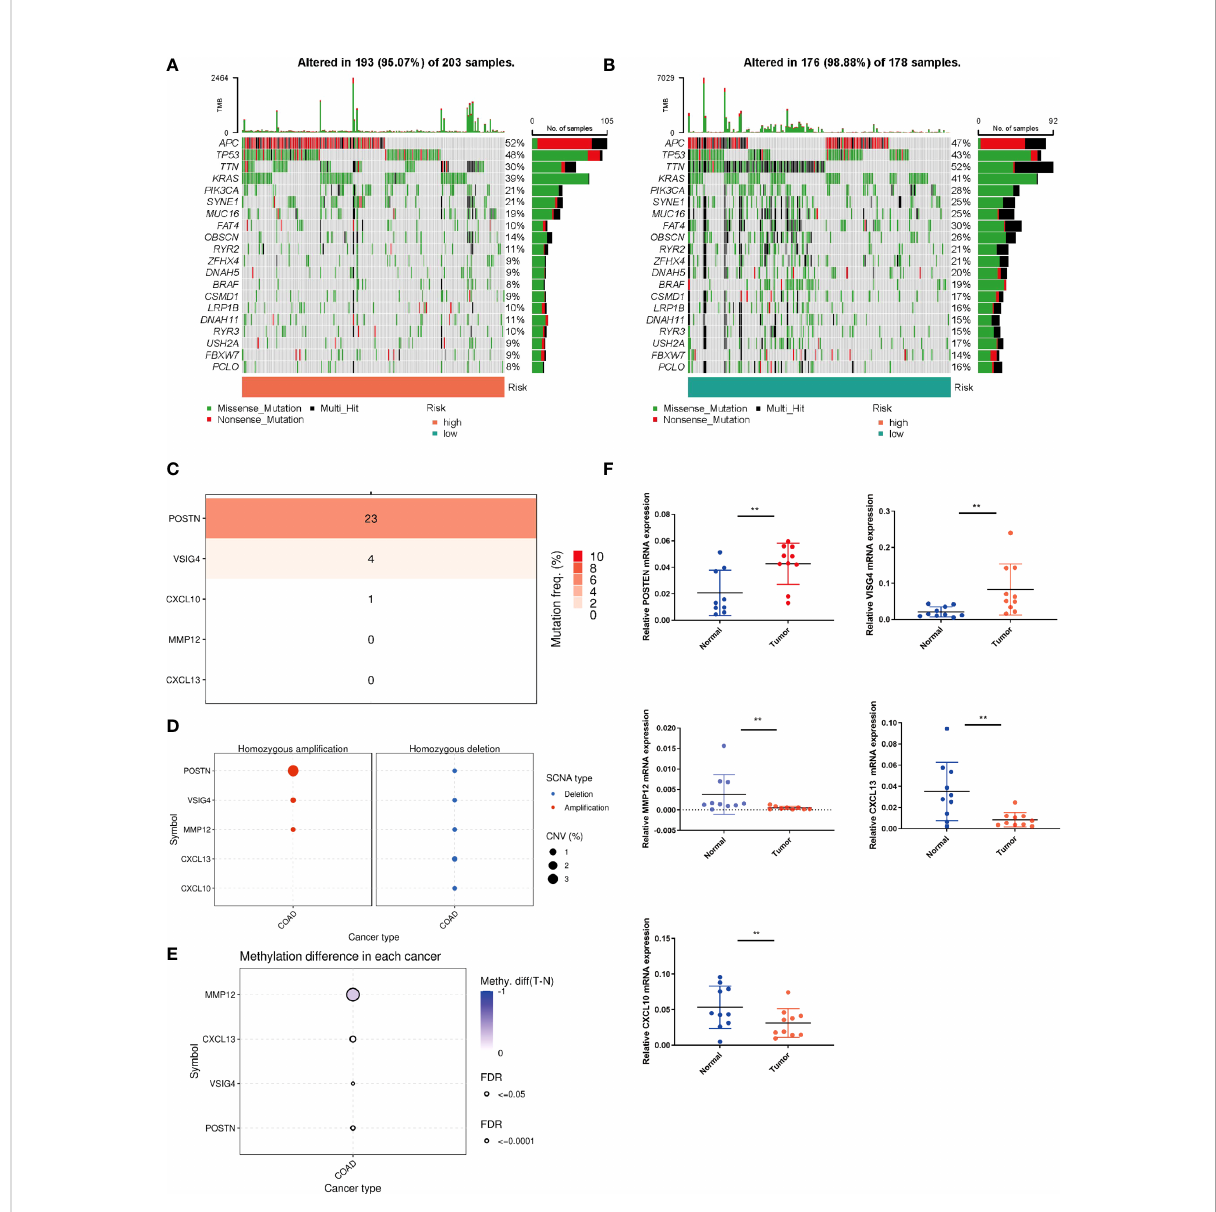
FIGURE 7 Mutation status in different risk subgroups. Waterfall maps of the somatic mutations in the high-risk group (A) and the low-risk group (B) . (C) Mutation rates of fi ve genes (POSTN, VISG4, CXCL10, CXCL13, MMP12) in COAD patients. (D) Frequencies of CNV gain and loss among fi ve PRRs. (E) Methylation analysis of four genes (POSTN, VISG4, CXCL13, MMP12) in COAD patients. (F) The expression levels of fi ve PRRs in 10 paired COAD and matched adjacent normal tissues were examined by q-PCR. **P <